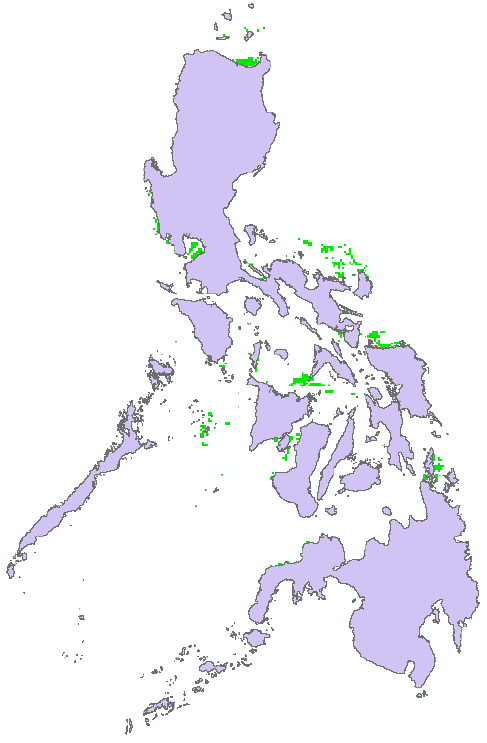
Figure 24. Offshore wind farms sites for 6.2M126.